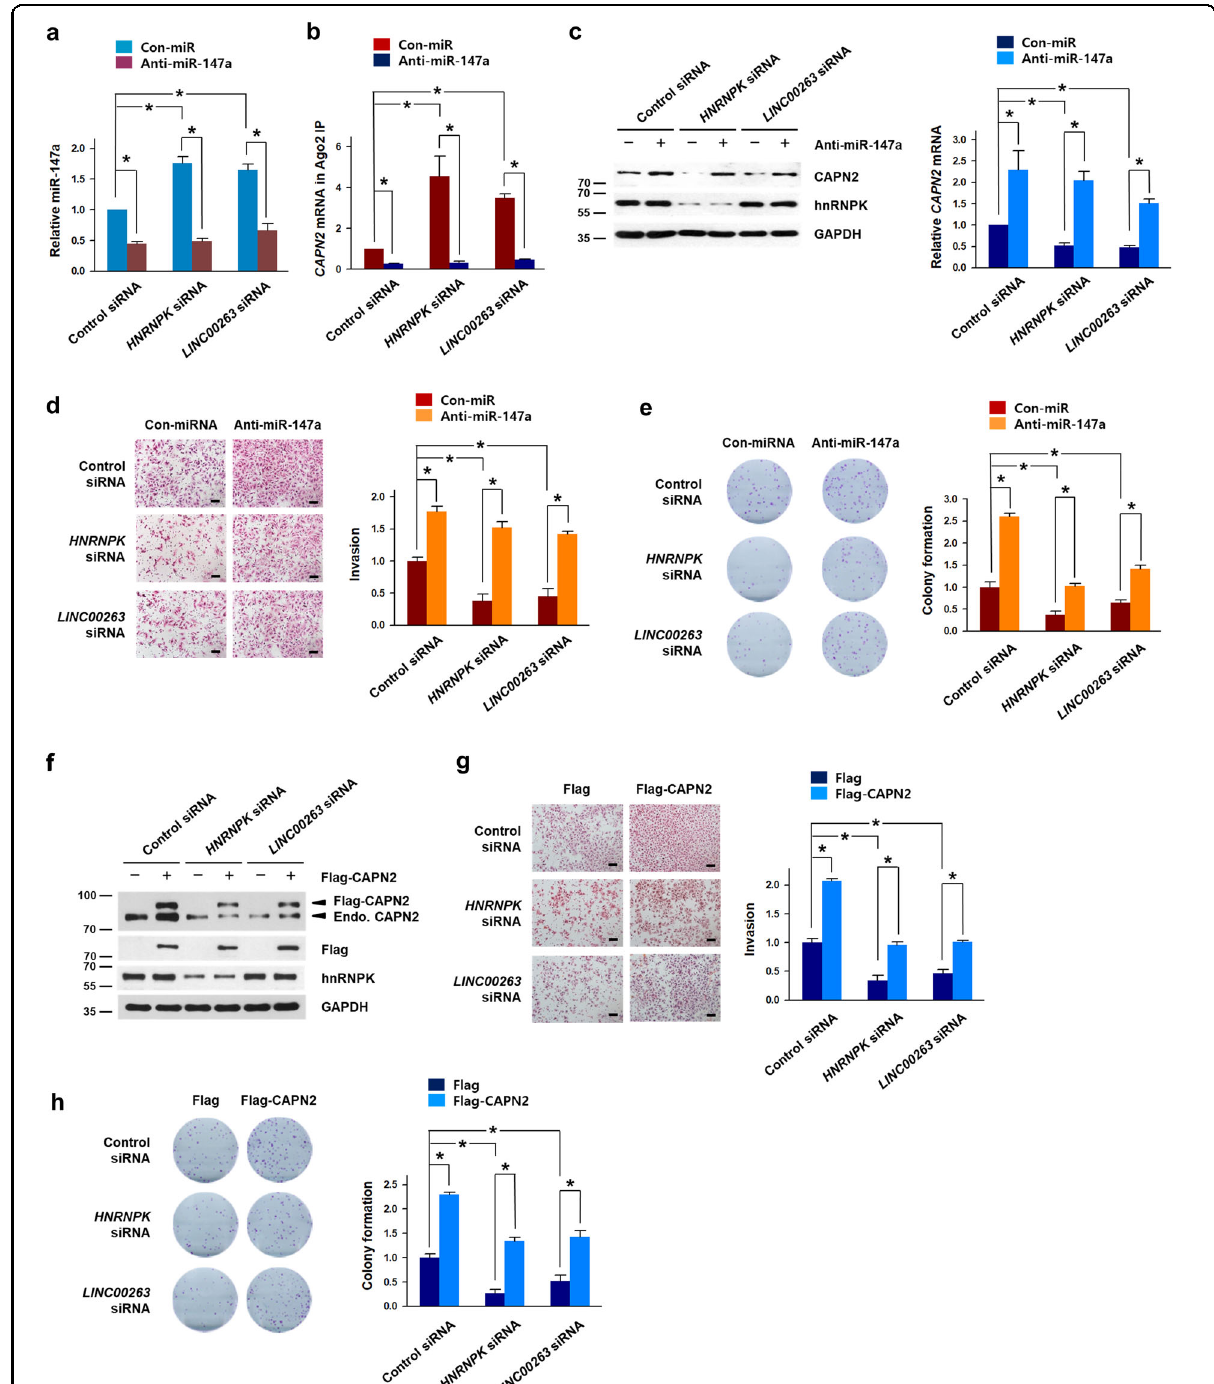
Fig. 6 Repression of malignant phenotypes following knockdown of hnRNPK and LINC00263 is restored by inhibition of miR-147a or ectopic expression of CAPN2. a – e To examine whether inhibition of miR-147a restores the malignant capabilities, siRNAs for hnRNPK or LINC00263 were introduced into HeLa cells with control miRNA or anti-miR-147a. Following isolation of total RNA, the level of miR-147a was determined by RT-qPCR analysis ( a ). Ago2 RNP-IP experiment was performed using the cytoplasmic lysates. The level of CAPN2 mRNA in Ago2 IP material was determined by RT-qPCR analysis ( b ). The expression levels of CAPN2 protein and mRNA were determined by Western blot and RT-qPCR analyses, respectively ( c ). Invasiveness ( d ) and colony- forming ability ( e ) were examined as described in “ Materials and methods ” . f – h For the rescue experiments, CAPN2 was ectopically overexpressed in hnRNPK- or LINC00263 -silenced HeLa cells. The protein level of CAPN2 was determined by Western blot analysis ( f ). Invasiveness ( g ) and colony-forming ability ( h ) were examined as described in “ Materials and methods ” . Bars on microscopic images represent 100 μ m. Statistical analyses were performed using the Student ’ s t test using three independent experiments (* p <0.05). All data represent mean±standard variation